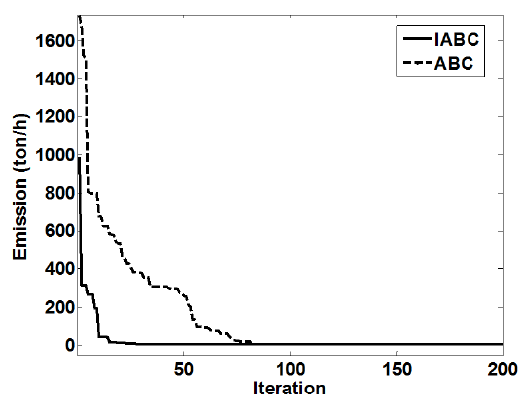
Figure 13. Convergence characteristics of emissions of the IABC and ABC algorithm for the IEEE 57-bus system.